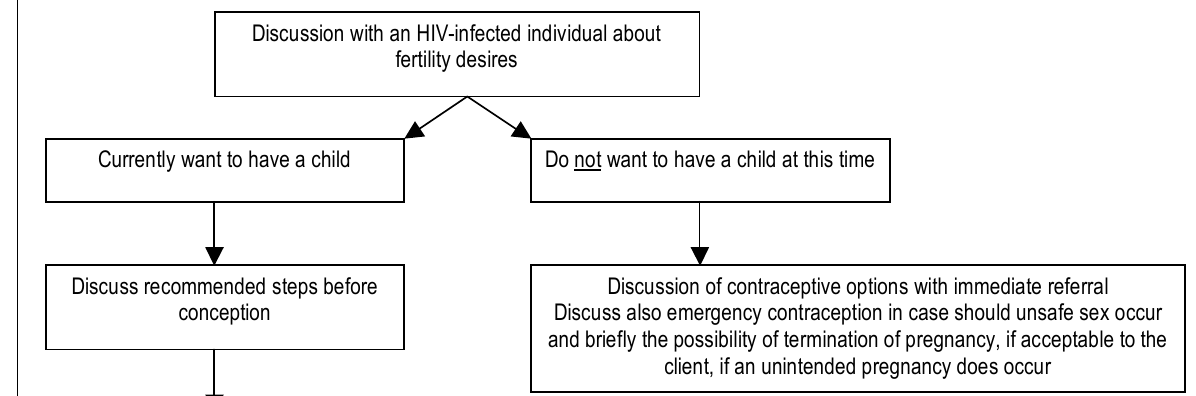
Figure 1. Flow diagram to approach pregnancy-related issues in HIV-infected women and men